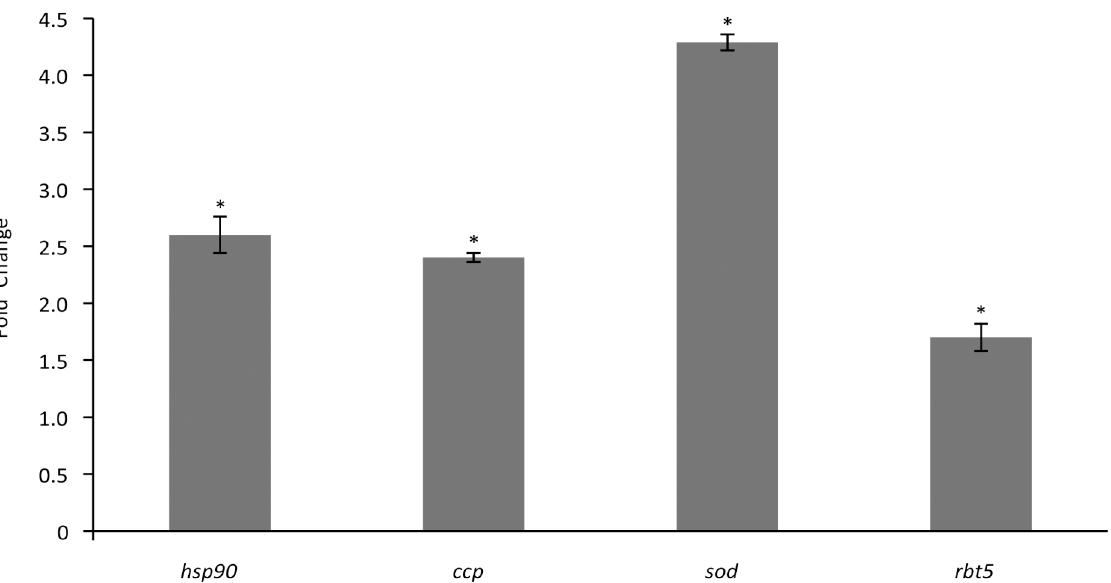
Fig 4. Effect of argentilactone on transcript expression levels in Paracoccidioides lutzii yeast cells. The expression levels of hsp90 , ccp , sod and rbt5 genes in Paracoccidoides spp. yeast cells grown in MMcM liquid medium with or without argentilactone were analyzed. The data were normalized using the constitutive gene encoding α -tubulin as the endogenous control and are presented as relative expression in comparison to the experimental control cells, whose value was set to 1. Data are expressed as the mean ± standard deviation of the triplicates of independent experiments. * , significantly different from the control at a p- value of <